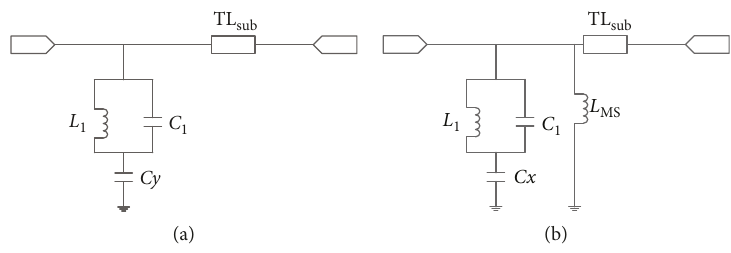
Figure 3: Circuit models for single FSS (a) y -direction and (b) x -direction.